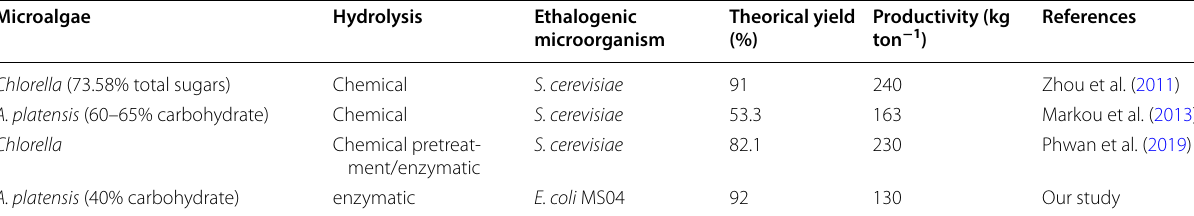
Table 4 Comparative productivities (kg ton − 1 ) from microalgae with potentiality to bioethanol production